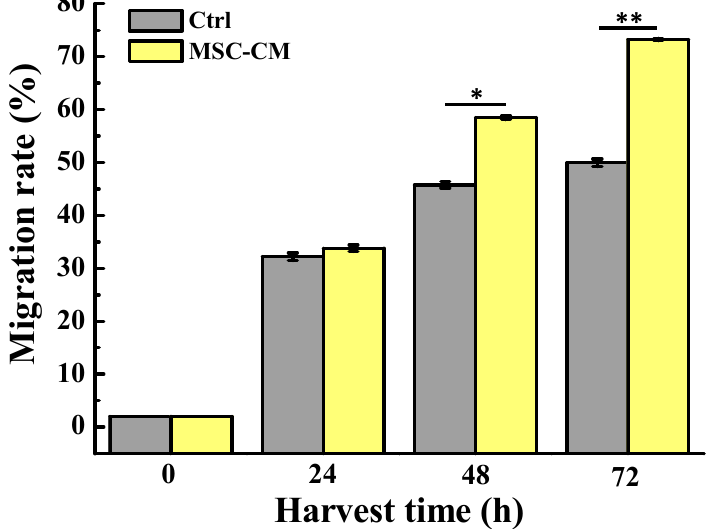
Figure 2. Quantitative evaluation of the wound healing reflecting the migration rate of the cells around the wound at various time intervals (* p < 0.05 and ** p < 0.01).